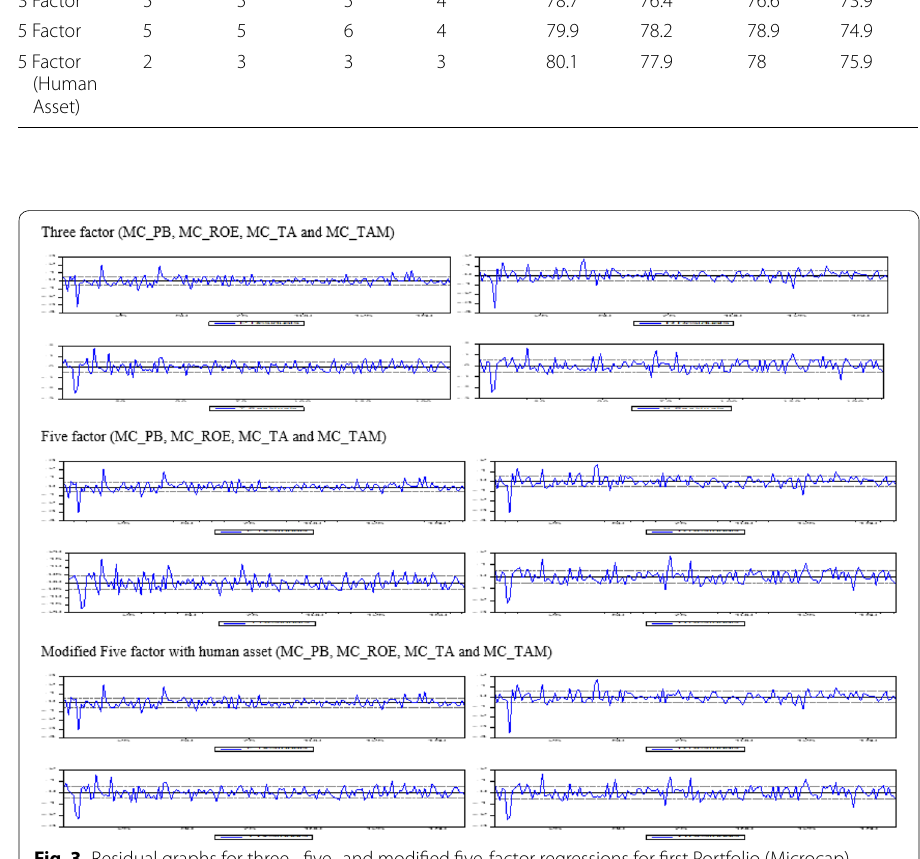
Fig. 3 Residual graphs for three-, five- and modified five-factor regressions for first Portfolio